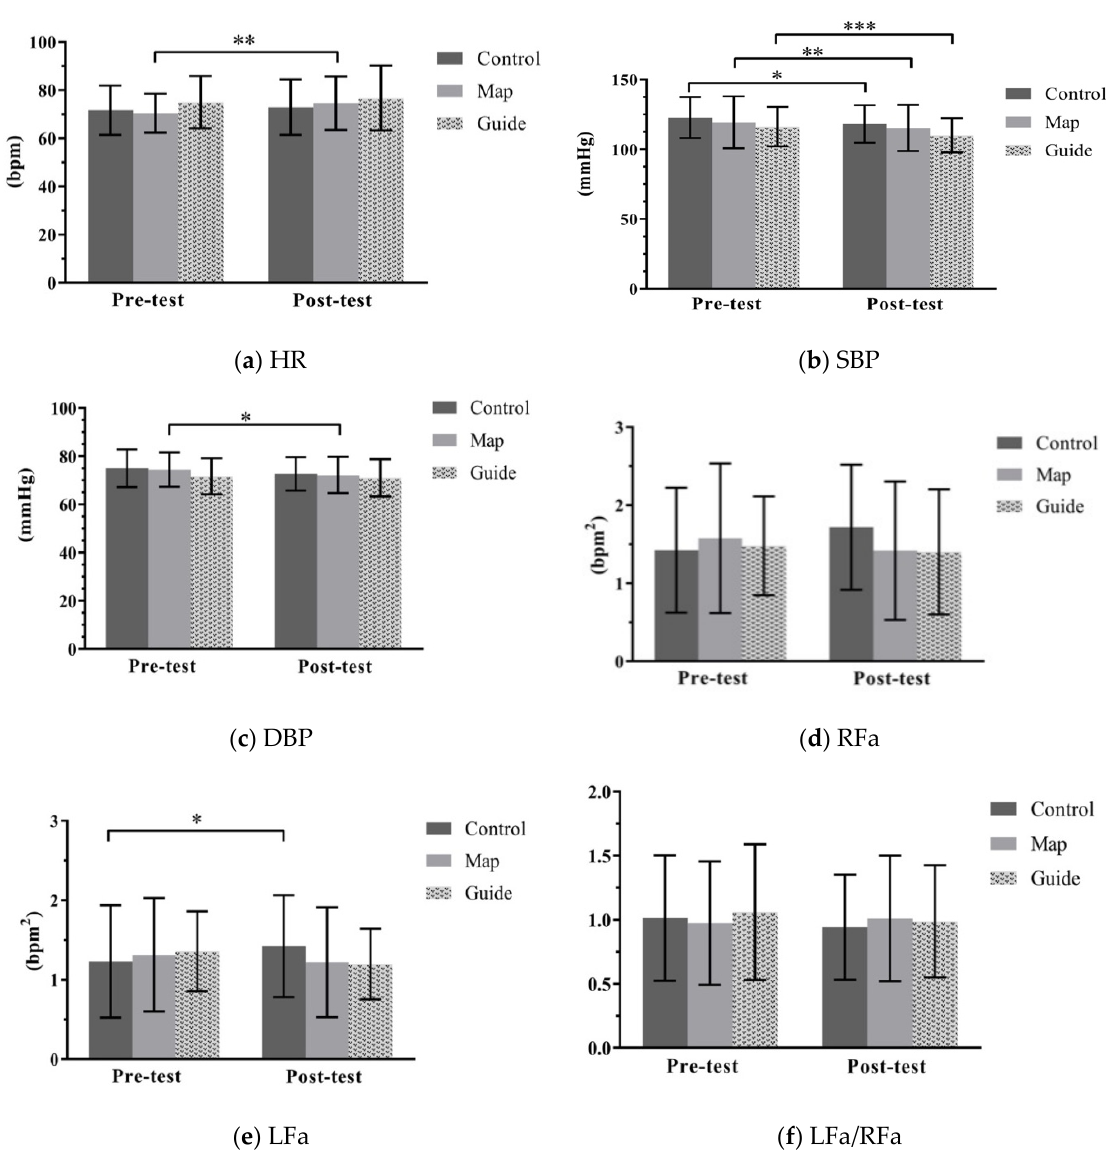
Figure 3. Pretest–posttest comparisons of physiological measures across the three groups. Abbreviations: ( a ) HR, heart rate; ( b ) SBP, systolic blood pressure; ( c ) DBP, diastolic blood pressure; ( d ) RFa, respiratory frequency area (parasympathetic nervous system activity measure); ( e ) LFa, low frequency area (sympathetic nervous system activity measure); ( f ) LFa/RFa (measure of sympathovagal balance). Note: Error bars depict standard deviation. * p < 0.05, ** p < 0.01, *** p < 0.001.